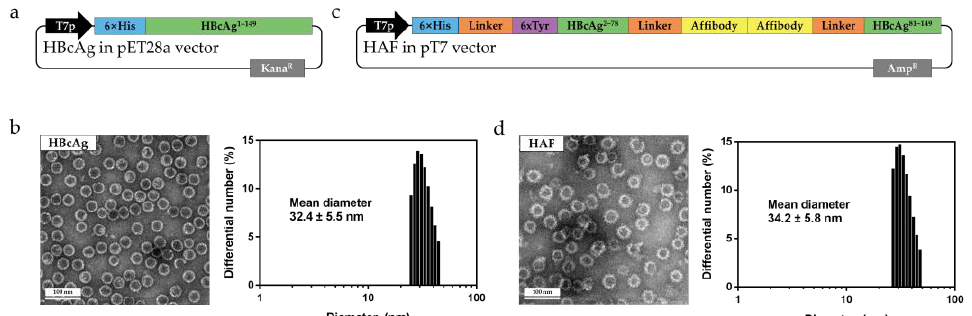
Figure 1. The recombinant plasmid map, TEM, and DLS of HBcAg and HAF. ( a ) Schematic plasmid vector used for expressing HBcAg. The construct is composed of the 6 × histidine tag followed by the N-terminal domain of HBcAg (aa 1–149). ( b ) TEM and DLS analysis of purified HBcAg. The measured diameters of HBcAg from the TEM and DLS matched each other. ( c ) Schematic plasmid vector used for expressing HAF. The HBcAg (aa 1–149) was divided into two parts. The affibody was inserted for binding to EGFR. The 6 × histidine and 6 × tyrosine tags were used for binding to the gold ions. ( d ) TEM and DLS analysis of purified HAF. The mean diameters of HAF from the TEM and DLS were in agreement.